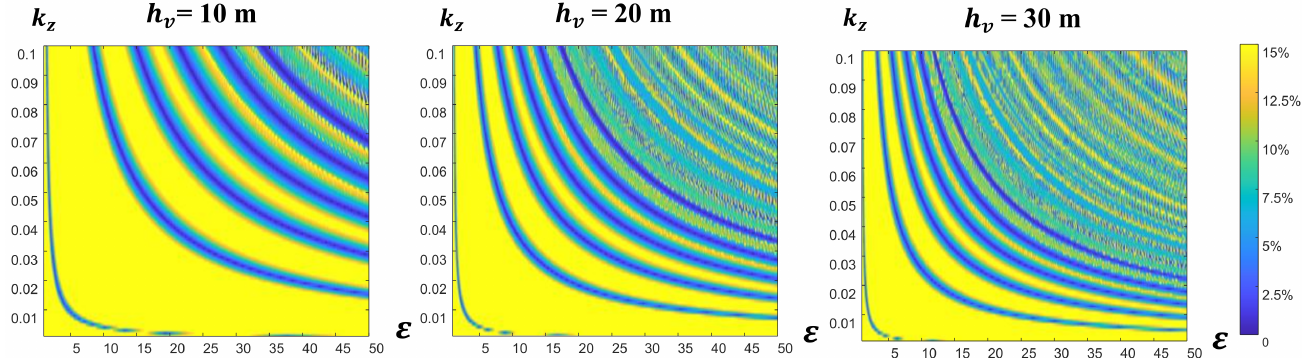
Figure 10. Distribution of relative inversion error of forest height with variation of k z and ε under different h v . The relative error is defined by | h v − h True | / h True × 100%, γ Tmp is set to 0.5 × e 0.3 i , σ is 0.2, k z ranges from 0 to 0.1, and ε ranges from 1 to